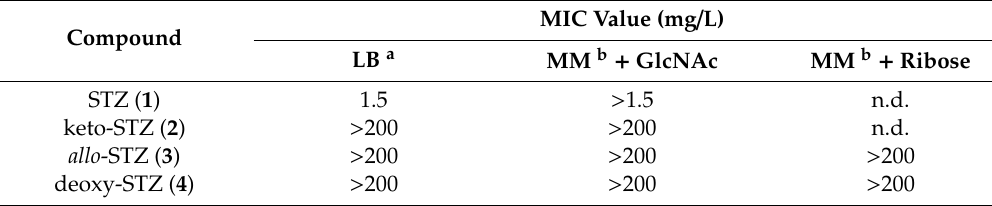
Table 1. Results from the minimum inhibitory concentration (MIC) assays using compounds 1 – 4 .